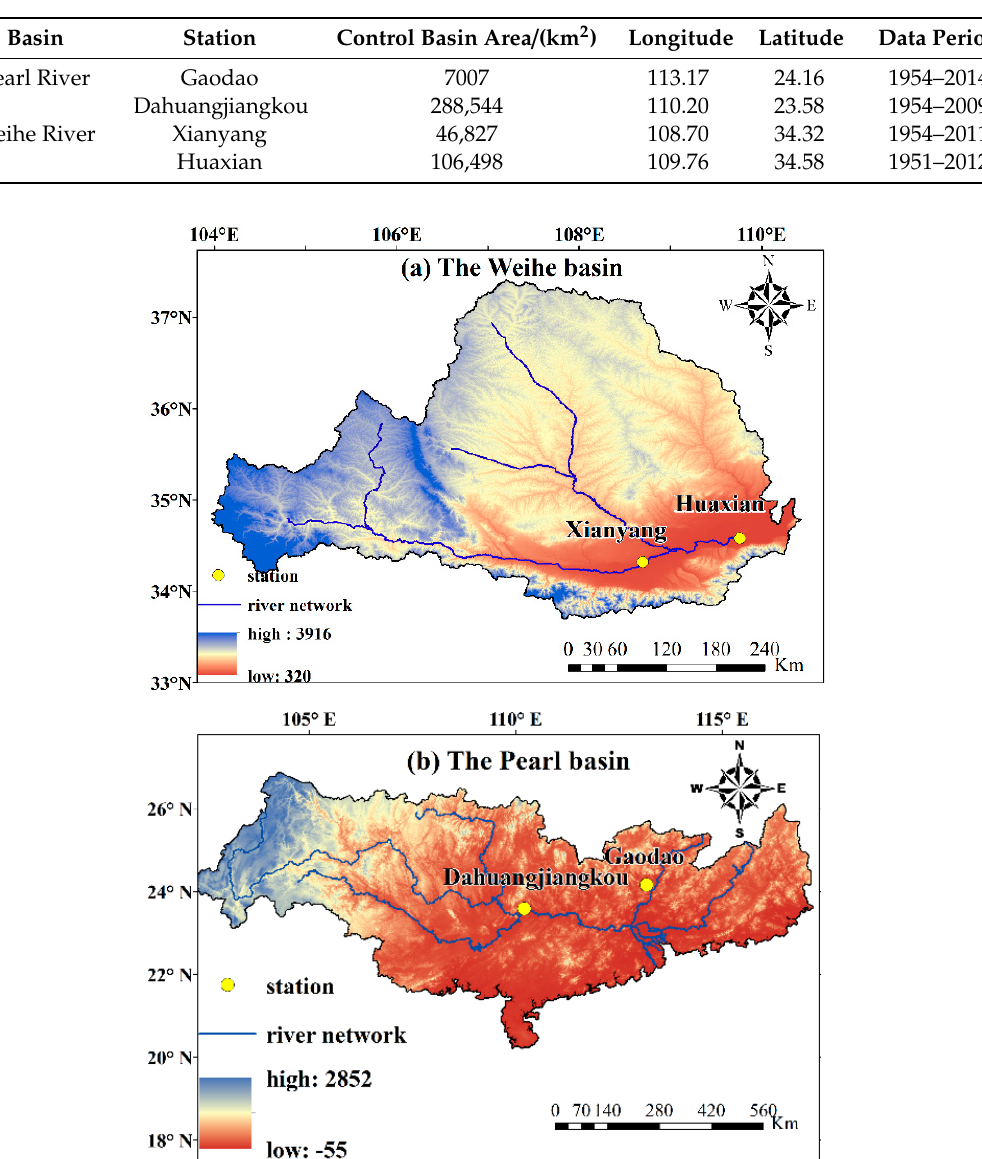
Figure 1. Location maps of the hydrological stations of ( a ) the Weihe basin and ( b ) the Pearl basin.